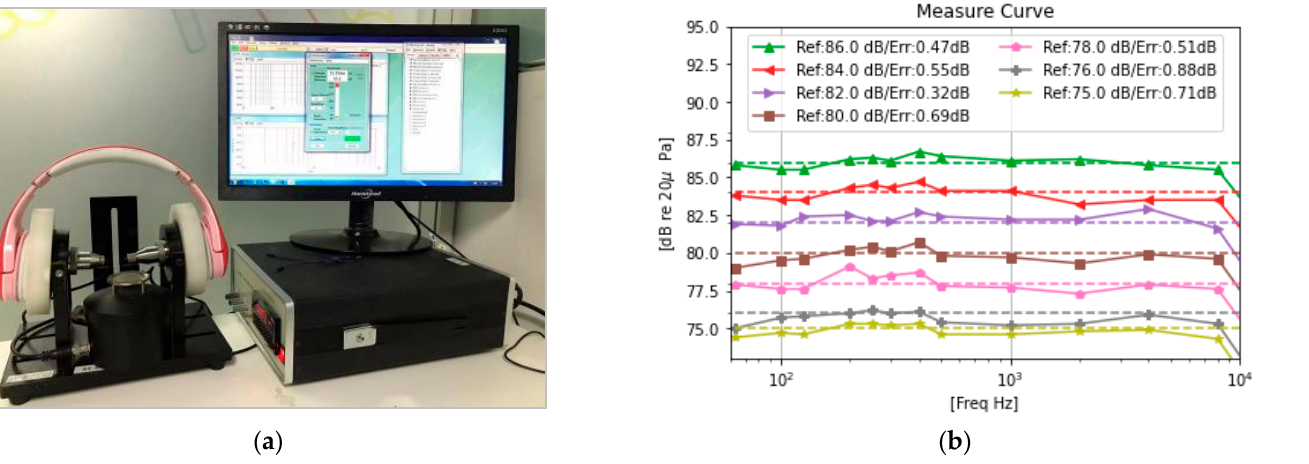
Figure 5. SPL Accuracy experiment platform and measurement result. ( a ) is the SPL measurement platform. Wear SL-PLD on artificial ear, connect with BT and play tone at different frequency and SPL; read the measured noise power. ( b ) is the real measured SPLs (dBA) from the measurement tool. The measured results are shown in Figure 5b. With frequency arranged from 60 Hz to 8000 Hz at the selected frequency point, the measured SPL is very close to the target SPL (dotted curve), and the max mean bias is about 98.8% (measured error 0.88 dBA at